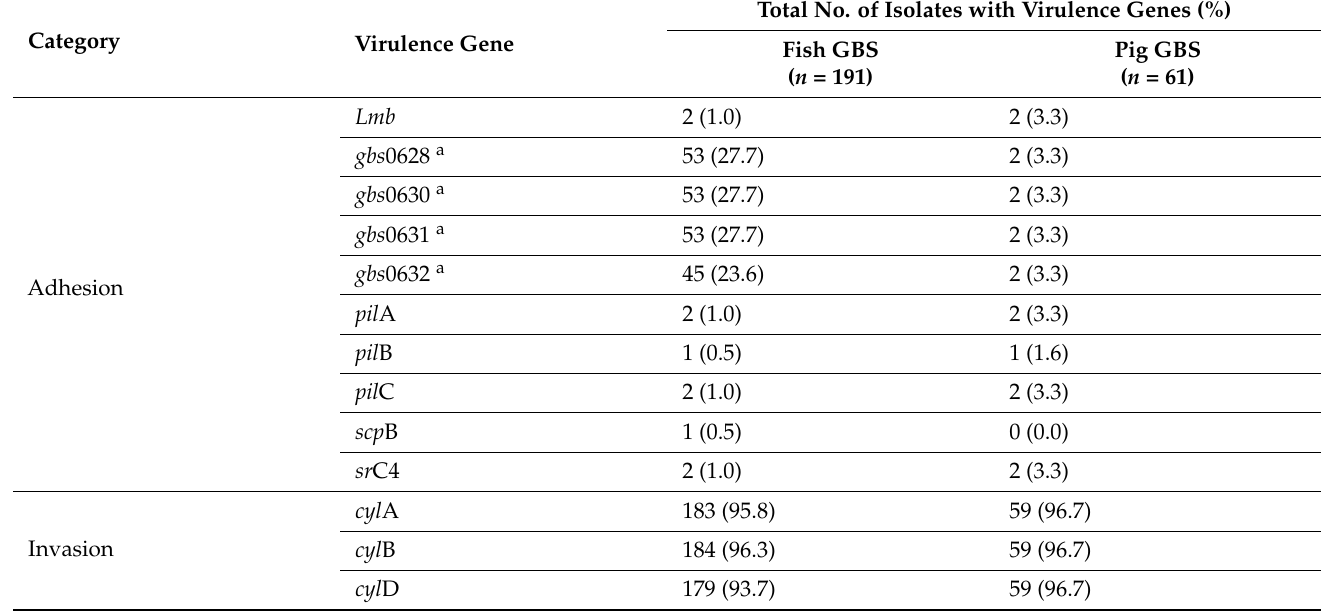
Table 6. Distribution of virulence genes between fish and pig GBS